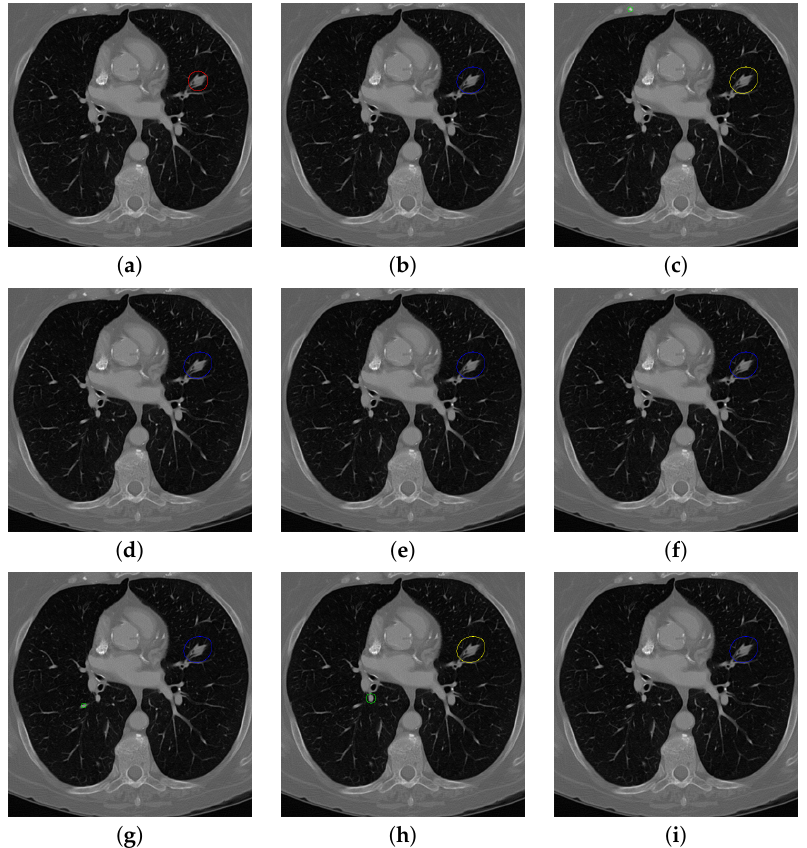
Figure 19. The result of detecting pulmonary nodules by different methods on one example image in TianChi dataset. Red circle represents the ground truth region of nodules, blue circles represent the correct estimation of pulmonary nodules, green circles represent the over-detected nodules, while yellow circles denote the nodules being omitted. ( a – i ) are: ground truth nodule in the given chest CT image, nodule detected by 3D-FCN, MR-CNN, 3D-UNET, PRN-HSN, DCNN, CLAHE-SVM, MASK-RCNN and our proposed